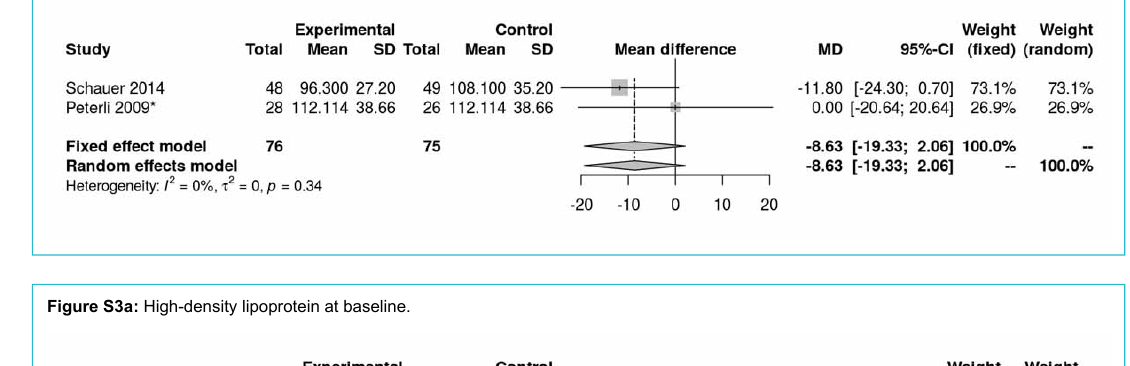
Figure S2c: Low-density lipoprotein at 36 months.